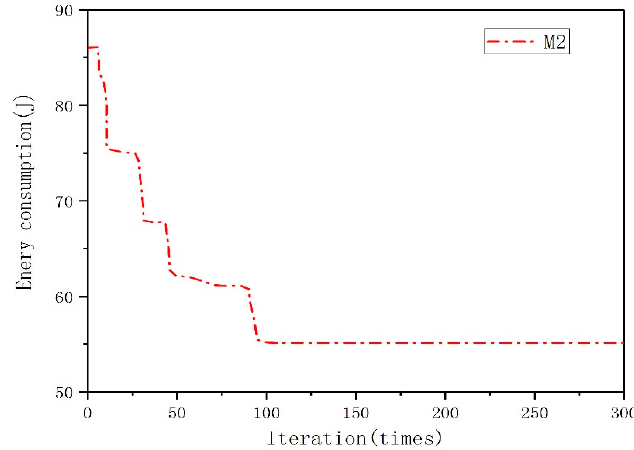
Figure 6. Energy consumption iterative curve of drilling machine.